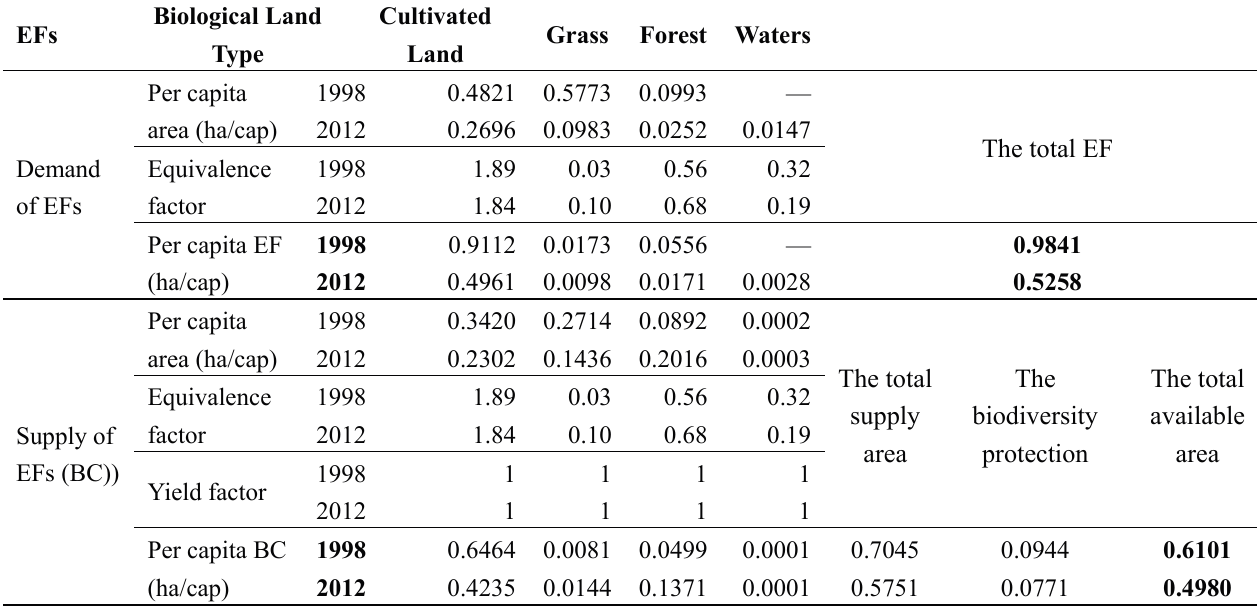
Table 3. The EFs and EC of consumption in Guyuan in 1998 and